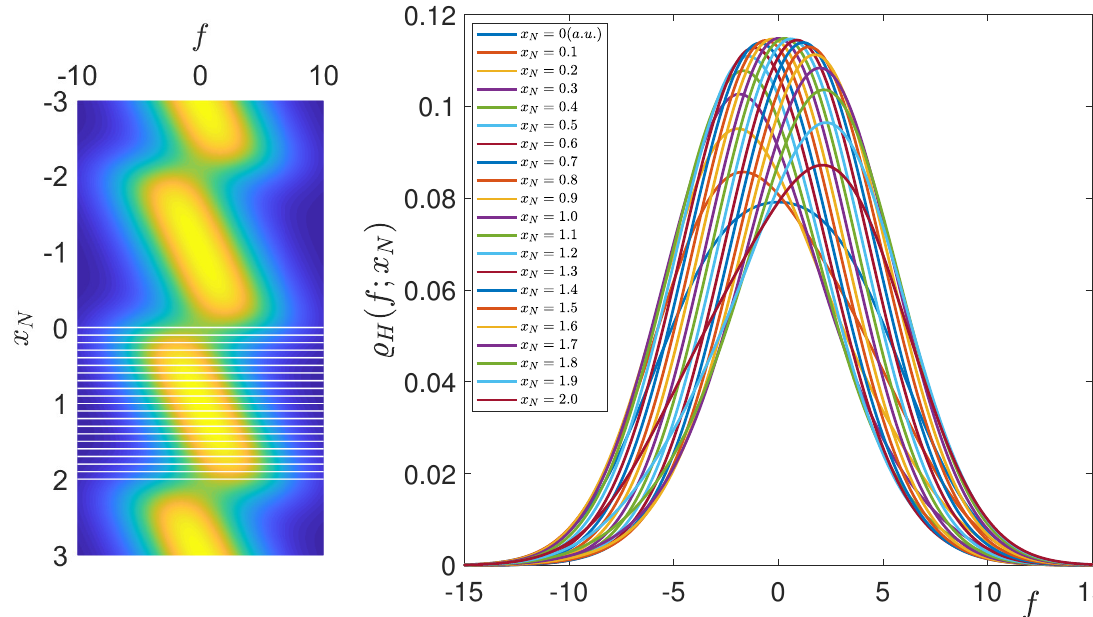
Figure 10. Examples of monomodal curves obtained through the Helmholtz density (cid:36) H ( f ; x N ) (see Equation (54)). On the left panel, the two-dimensional representation of the Helmholtz density is shown with the cuts corresponding to the curves plotted on the right panel. We used N = 5, (cid:96) = 1 (a.u.), k = 15 (a.u.), k B T = 1 (a.u.) and different values of the prescribed position x N , as indicated in the legend.